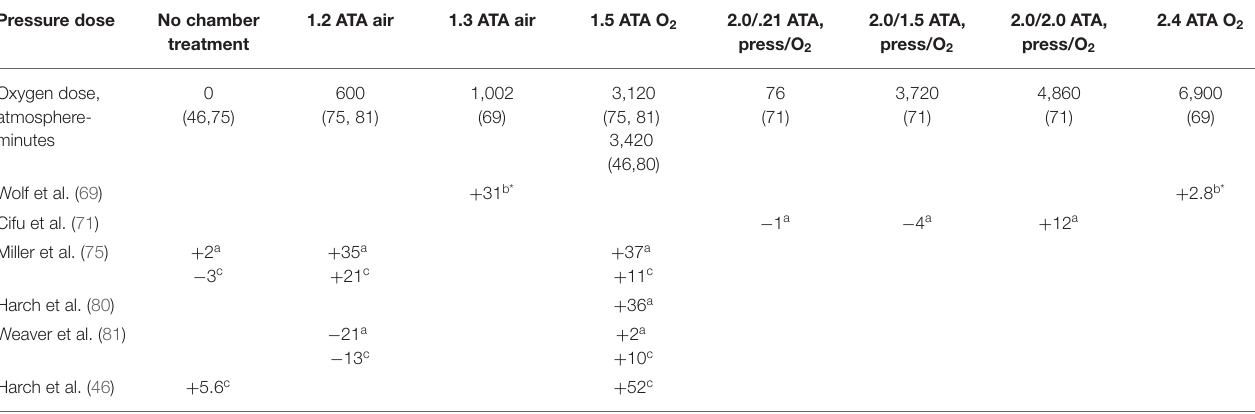
TABLE 2 | Immediate post-treatment symptom changes according to pressure and oxygen dose in mTBI PPCS studies, abstracted from Table 7 in Harch et al. (46) with change in polarity. Pressure dose